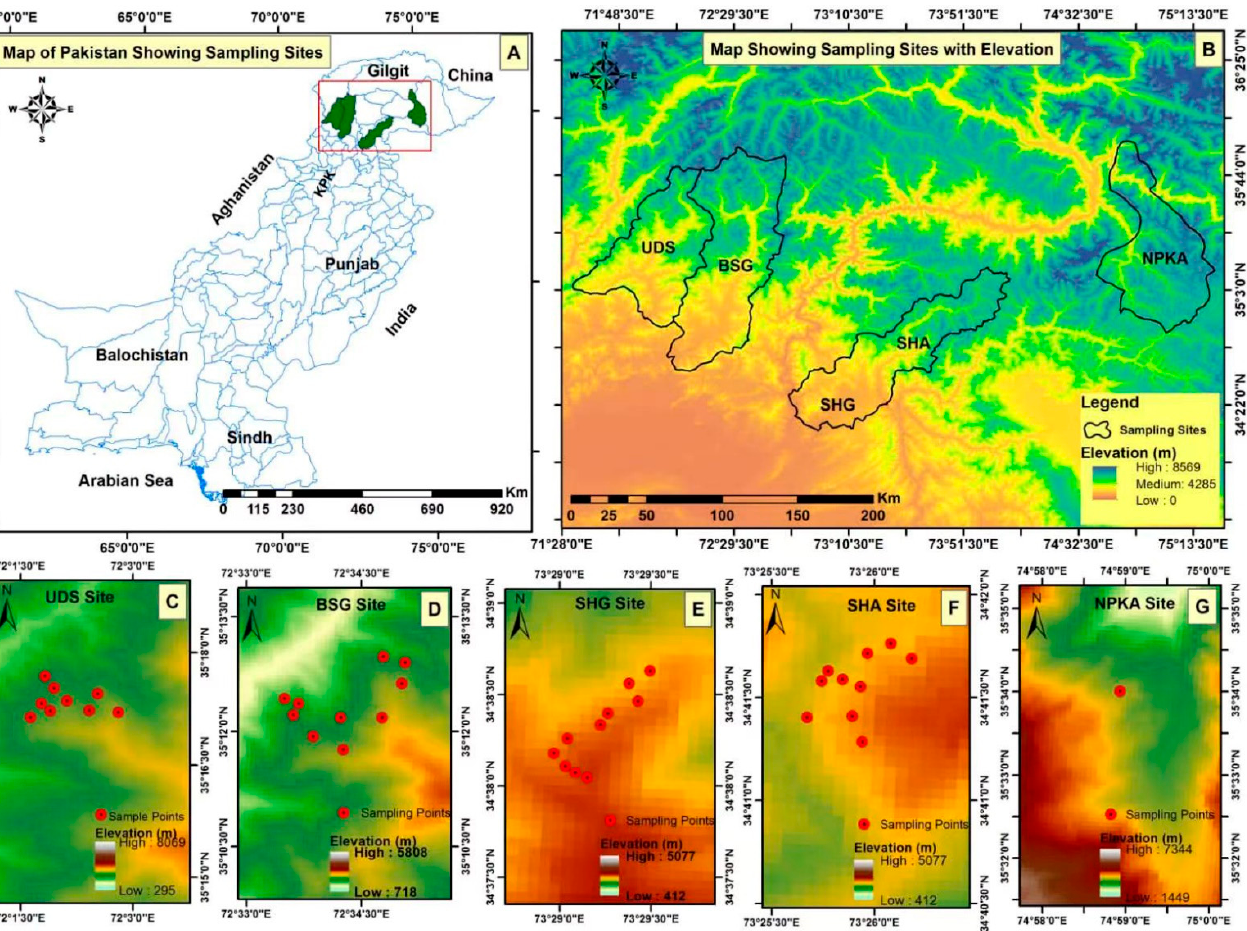
Figure 1. Map showing the study sites and elevation in Northern Pakistan. ( A ) Map of the Pakistan showing sampling sites, ( B ) Map showing sampling sites with elevation, ( C ) UDS site, ( D ) BSG site, ( E ) SHG site, ( F ) SHA site, and ( G ) NPKA site. The red circle shows sampling sites.